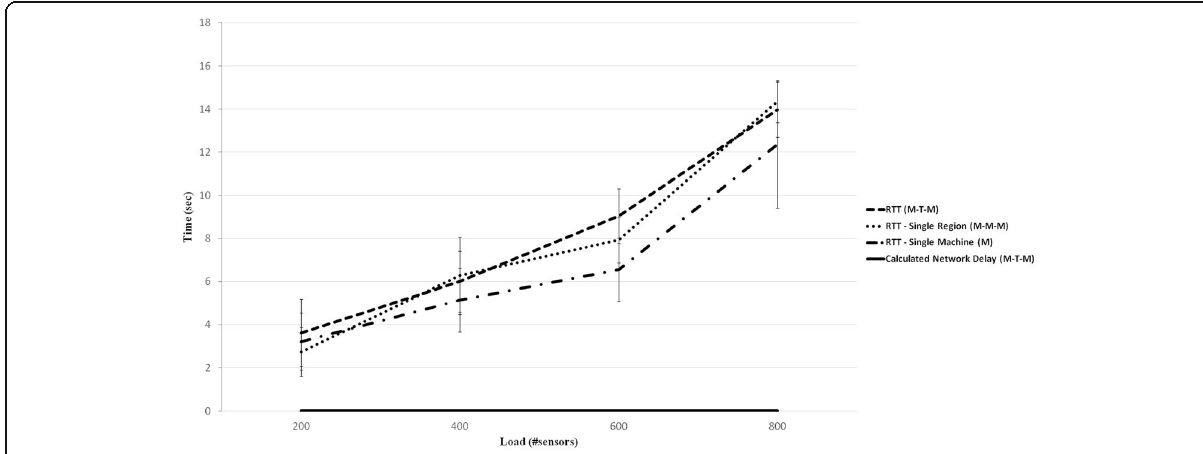
Fig. 9 Average RTT of Modbus